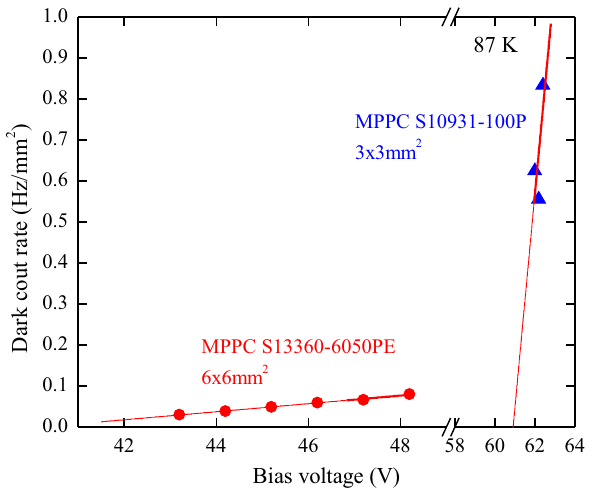
The detector was a two-phase LAr time-projection cham- ber (TPC) composed of the drift (48 mm thick) and electron emission (4 mm thick) regions, in the liquid phase, and the EL gap(18mmthick),inthegasphase.Toformtheseregions,we used THGEM (Thick Gas Electron Multipliers, [33]) elec- trodes instead of the more conventional wire grids, provid- ing the advantage of electrode rigidity that allowed to avoid wire grid sagging. All electrodes had the same active area of 10 × 10 cm 2 . The THGEM geometrical parameters were the following: dielectric (FR-4) thickness of 0.4 mm, hole pitch of 0.9 mm, hole diameter of 0.5 mm and hole rim of 0.1 mm, optical transparency at normal incidence of 28%. The drift region was formed by a cathode electrode, field-shaping electrodes and THGEM0 (interface THGEM), immersed in the liquid layer. These were biased through a resistive high-voltage divider placed within the liquid. THGEM0 was biased in a way to provide a transmission of drifting electrons from the drift region to that of electron emission: the electrons drifted successively from a lower to higher electric field region. The electron transmission effi- ciency, defined by the voltage applied across THGEM0 and its geometrical parameters, was calculated in [34] to be 62%. THGEM1 was placed in the gas phase above the liquid and acted either as an anode of the EL gap (grounded through a resistor) or an electron multiplication element of the com- bined THGEM/SiPM-matrix multiplier (i.e. operated in elec- tron avalanche mode), coupled to the EL gap. The liquid level in the EL gap was monitored with an accu- racy of 0.5 mm, being calculated from the amount of